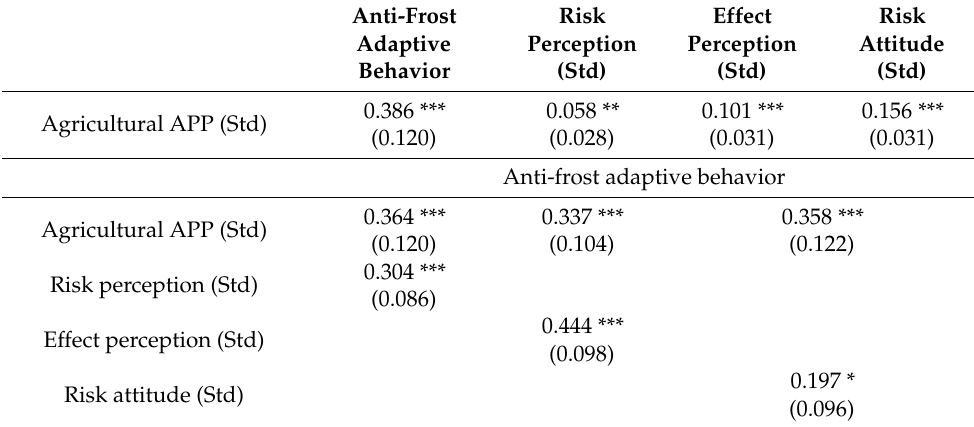
Table 10. The mediating effect of agricultural APP on anti-frost adaptive